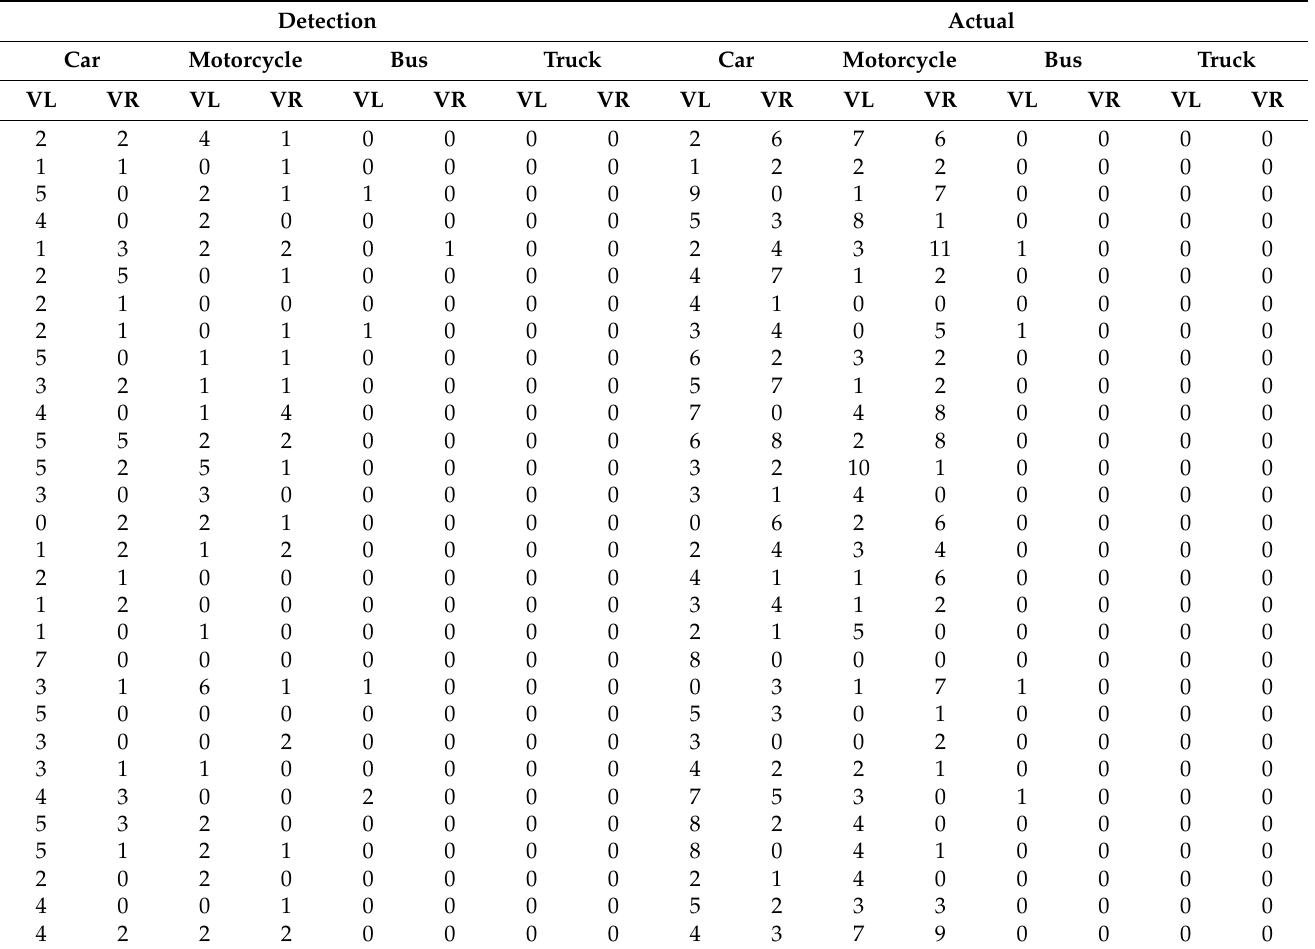
Table 7. Comparison between Detection and Actual Result on Pramuka–Cihapit Road Segment.